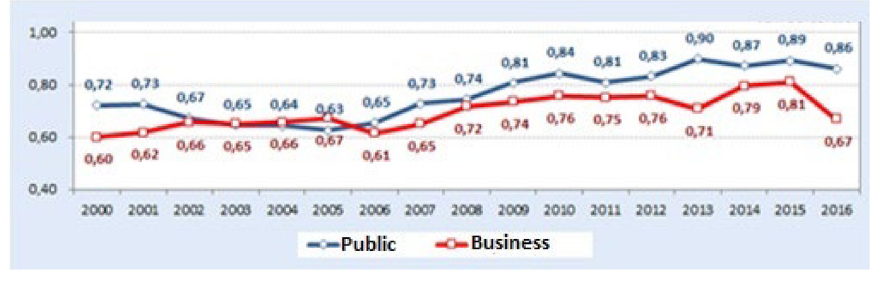
Figure 8. Brazil: national expenditure on science and technology